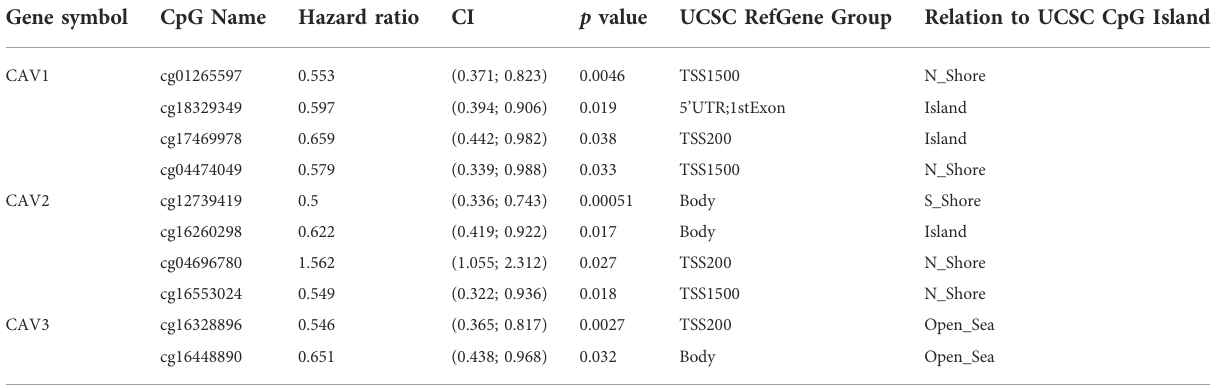
TABLE 1 Signi fi cant prognostic values of CpG in the CAV family members. Gene